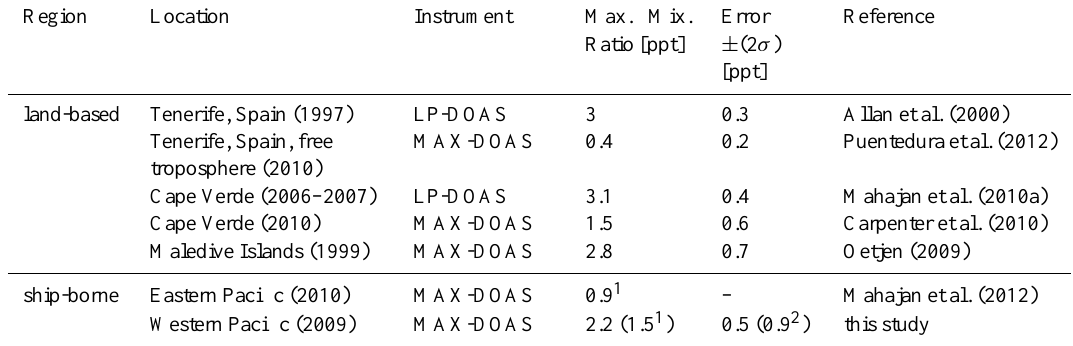
Table 1. Past open ocean ground-based observations of IO in the troposphere using the active and passive DOAS technique. Region Location Instrument Max. Mix. Error